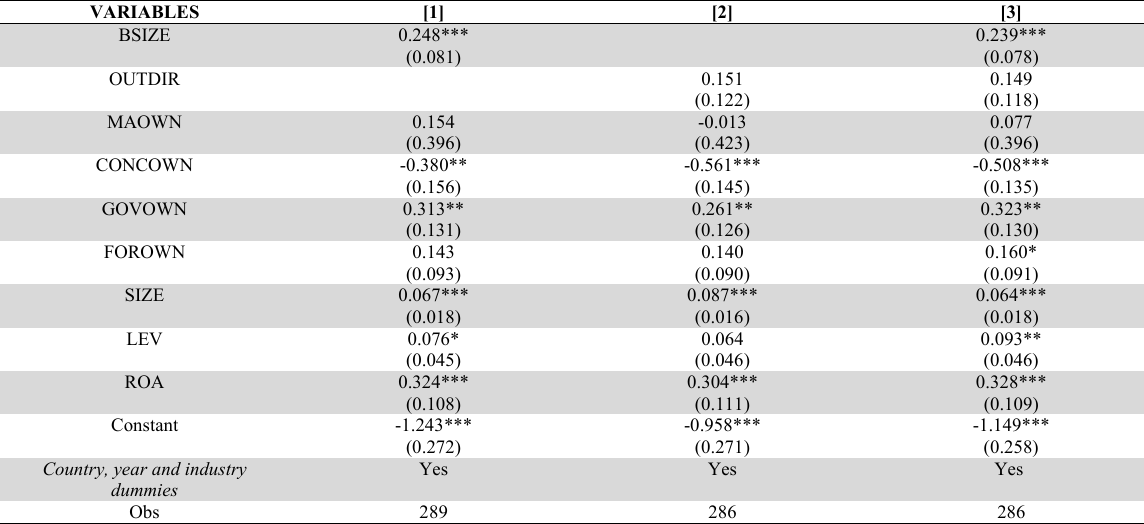
Fractional Probit regression